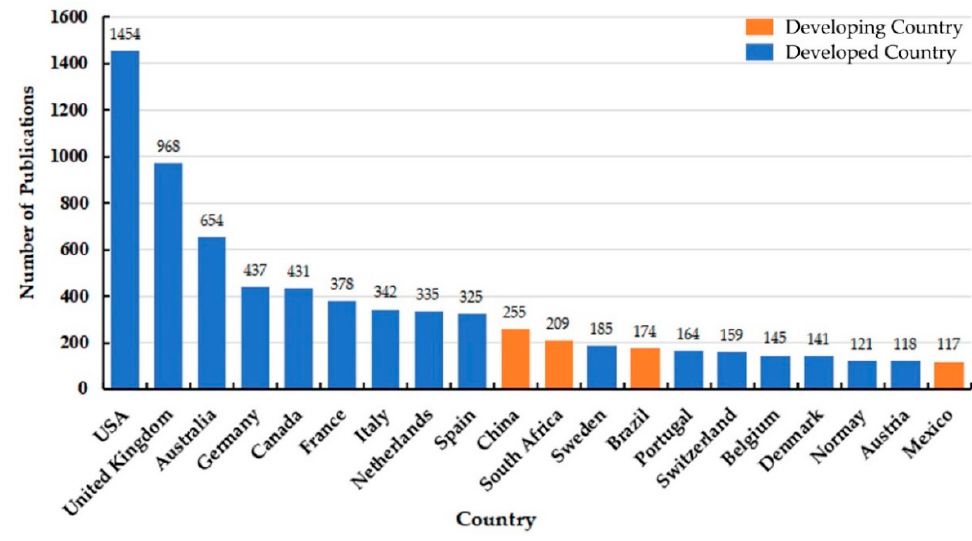
Figure 4. Top 20 countries with the total number of publications on NPAs from 2000 to 2021.